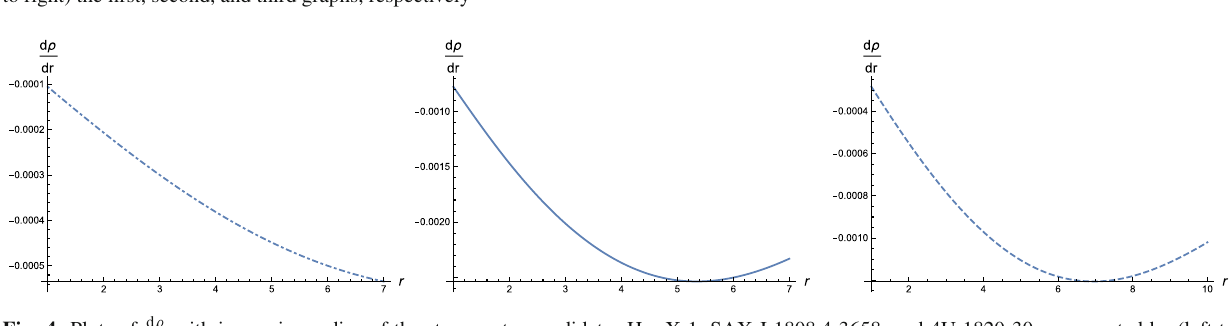
Fig. 3 Plots of the transverse pressure evolution of the strange star candidates Her X-1, SAX J 1808.4-3658, and 4U 1820-30; represented by (left to right) the first, second, and third graphs, respectively